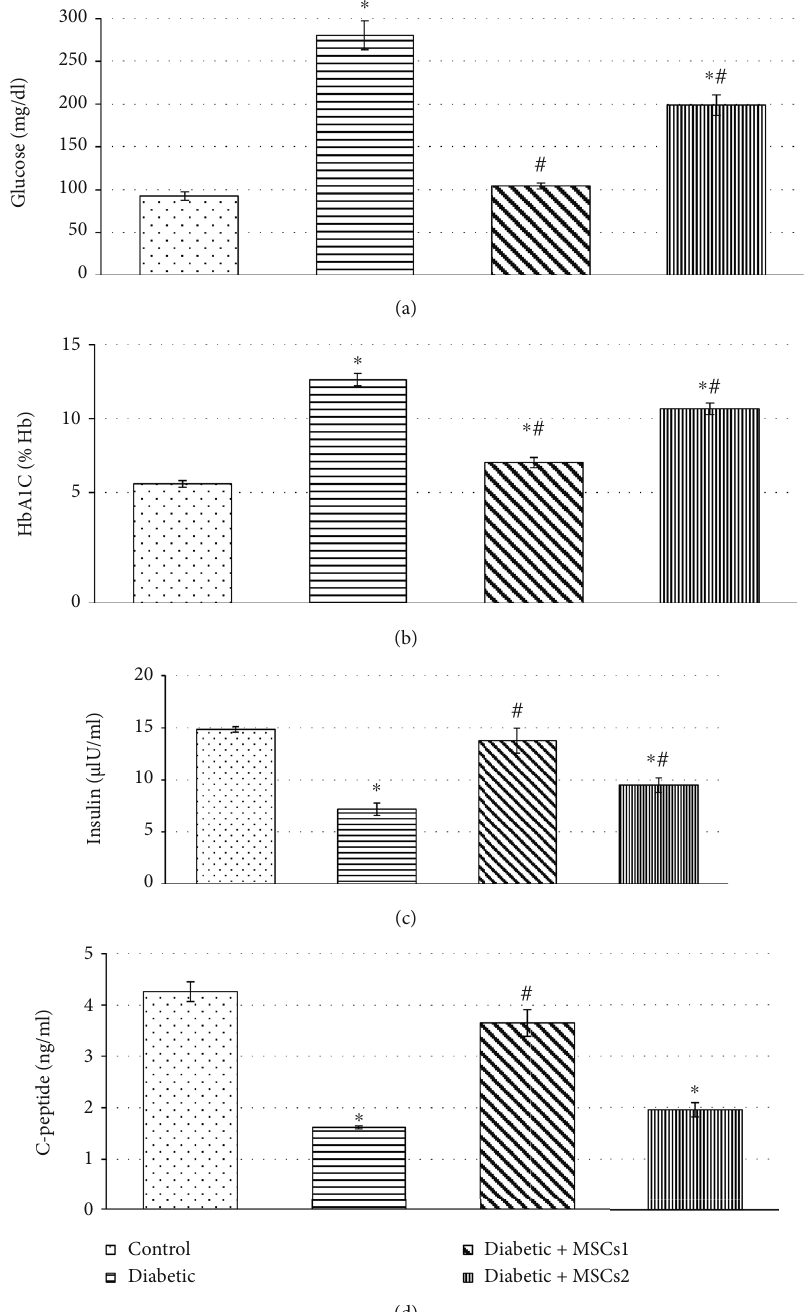
Figure 2: E ff ect of mesenchymal stem cell transplantation on serum levels of (a) glucose, (b) HbA1c, (c) insulin, and (d) C-peptide of the control and experimental groups of developing diabetic rats. Values are expressed as mean ± SEM ( n = 6 ). Comparisons are ∗ p ≤ 0 : 05 signi fi cantly di ff erent from the control group and # p ≤ 0 : 05 signi fi cantly di ff erent from the diabetic